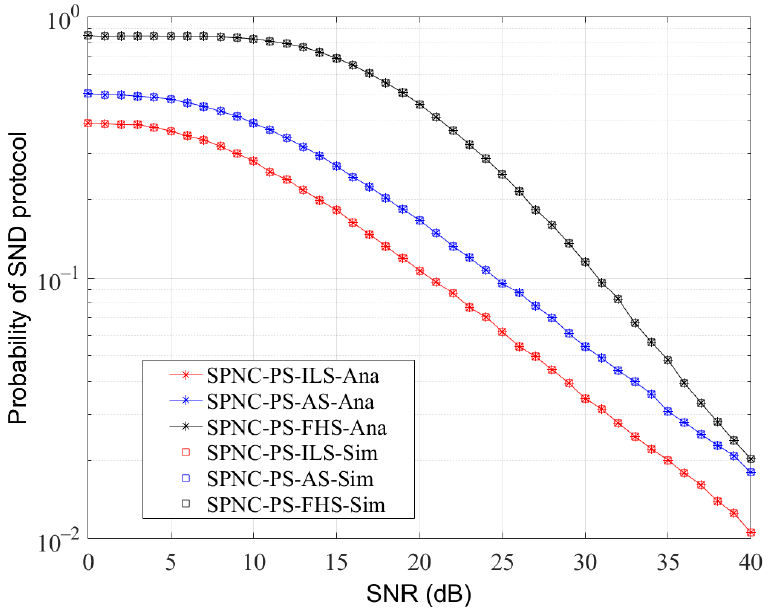
Figure 4. Probability of SND protocol versus the average SNR performance of SPNC protocol in PS aided two-way satellite-terrestrial relay network with ILS, AS, and FHS.